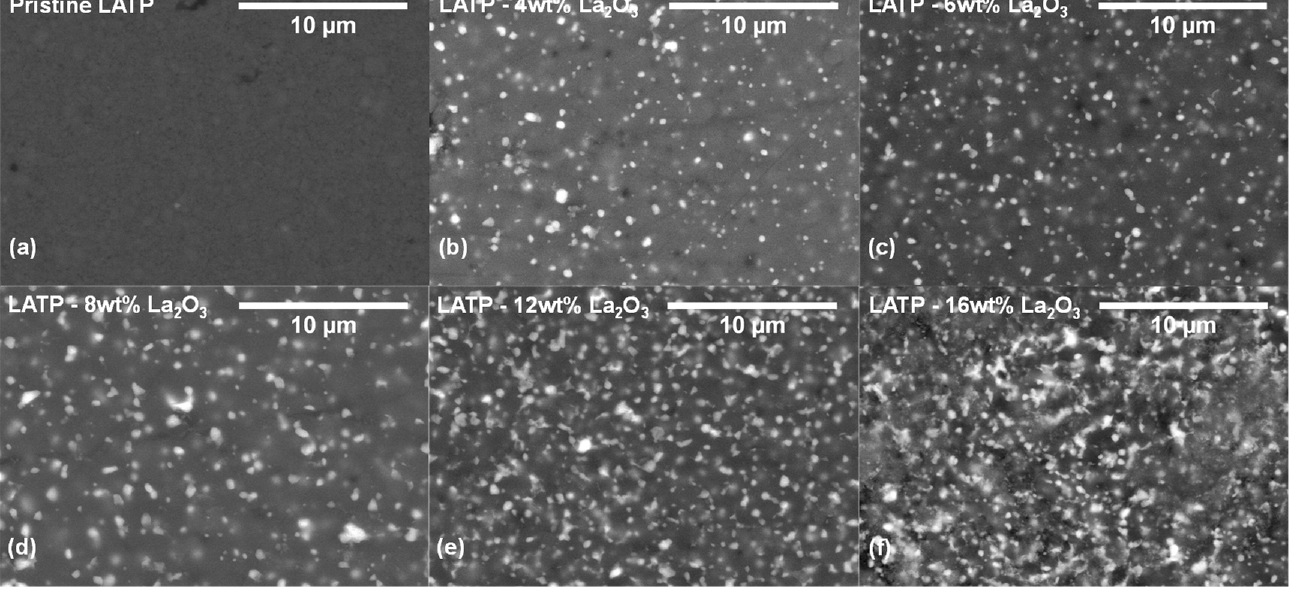
Figure 2. Back-scattering SEM images of ( a ) pristine LATP, ( b ) LATP–4 wt.%, ( c ) LATP–6 wt.%, ( d ) LATP–8 wt.%, ( e ) LATP–12 wt.%, and ( f ) LATP–16 wt.% La 2 O 3 .